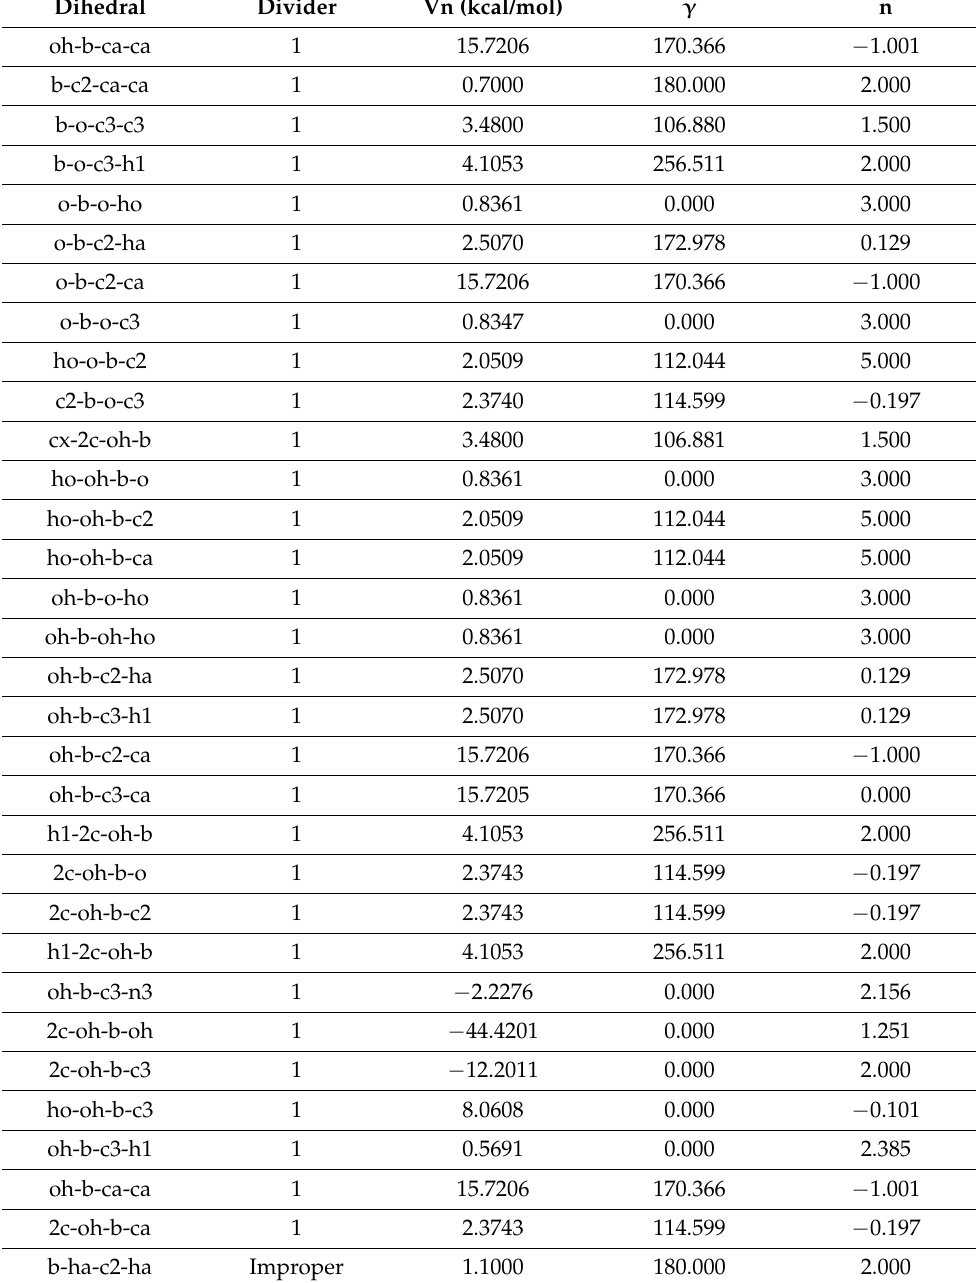
Table 1. Generated dihedral Amber parameters for compounds 1 – 4 , using the Paramfit procedure. For other dihedrals of the molecules, General Amber Force Field (GAFF) wildcard parameters were used. The atom names are indicated as in the GAFF/GAFF2 and ff14SB force field. Dihedral Divider Vn (kcal/mol)